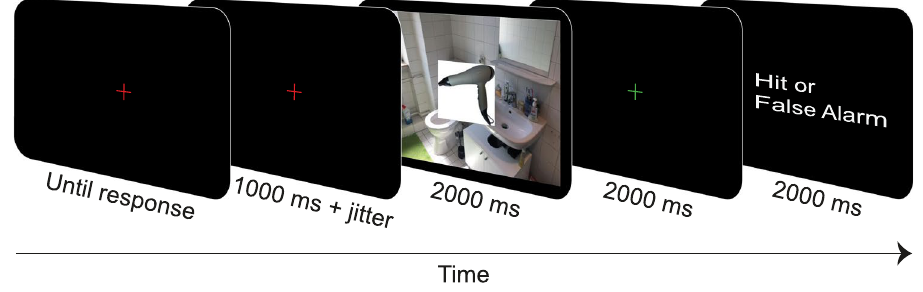
Figure 8. Trial sequence of the ERP experiment (slightly adapted for display